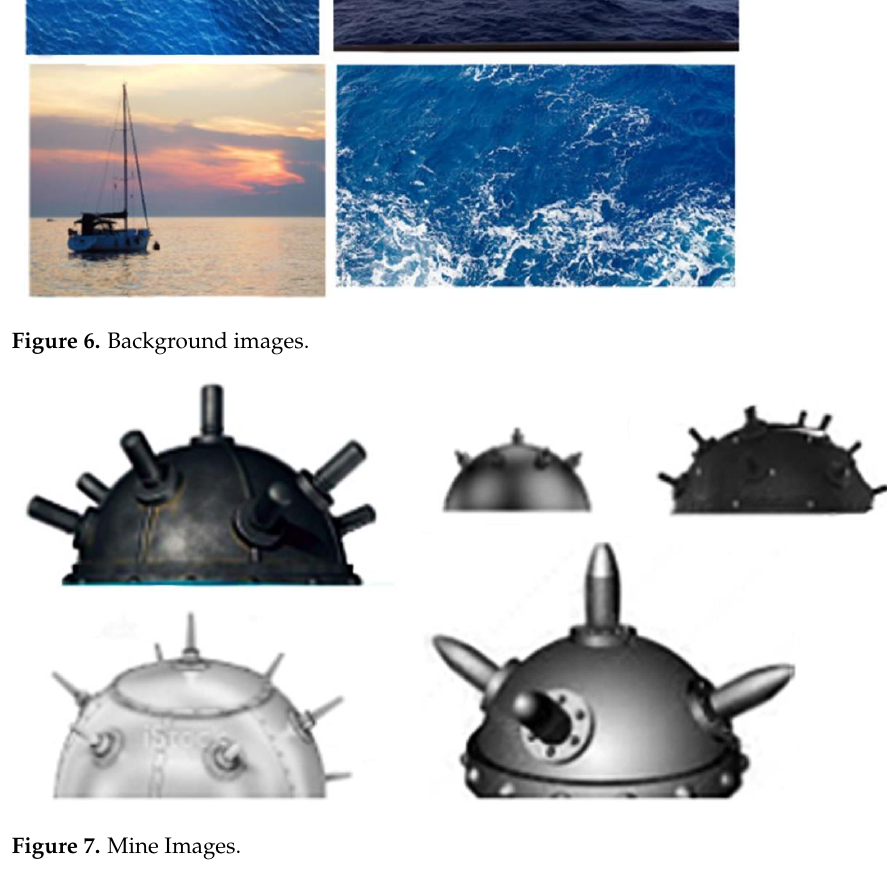
Figure 7. Mine Images.